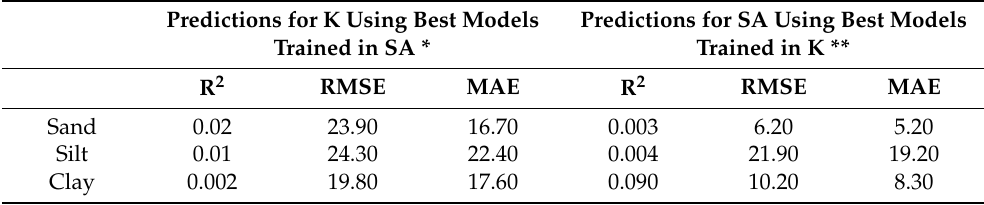
Table 5. Accuracy of best-fit models when applied to new regions in predicting soil texture fractions. Predictions for K Using Best Models Predictions for SA Using Best Models Trained in SA * Trained in K ** RMSE